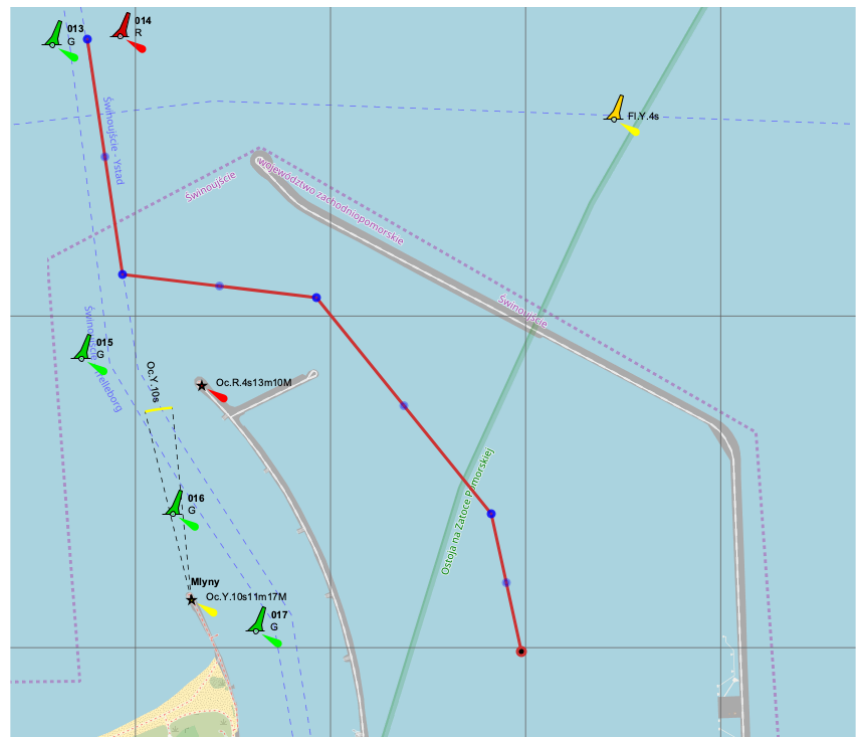
Figure 5. Navigational channel bend of Ś winouj ś cie port to LNG terminal area and ship’s sailing way, where: 013G, 014R, etc. – names of the buoys, Oc.Y.10s11m17M, Oc.Y.10s11m17M – characteristics and visibility distance of the lighthouses [21].